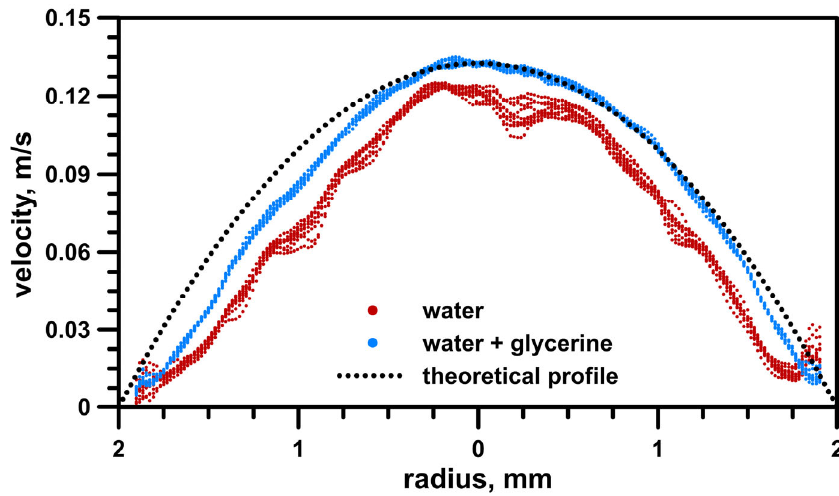
Figure 7. Axial velocity profile comparison of water flows, water + glycerin flows, and mathematical profile.